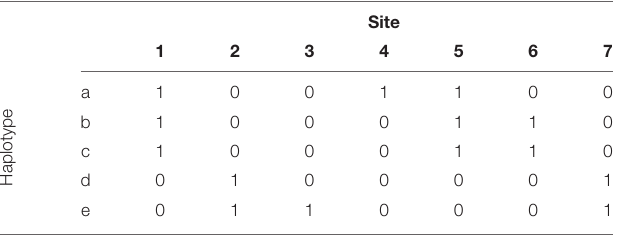
TABLE 1 | Example of 5 haplotypes spanning 7 mutations from Kelleher et al. (2019).